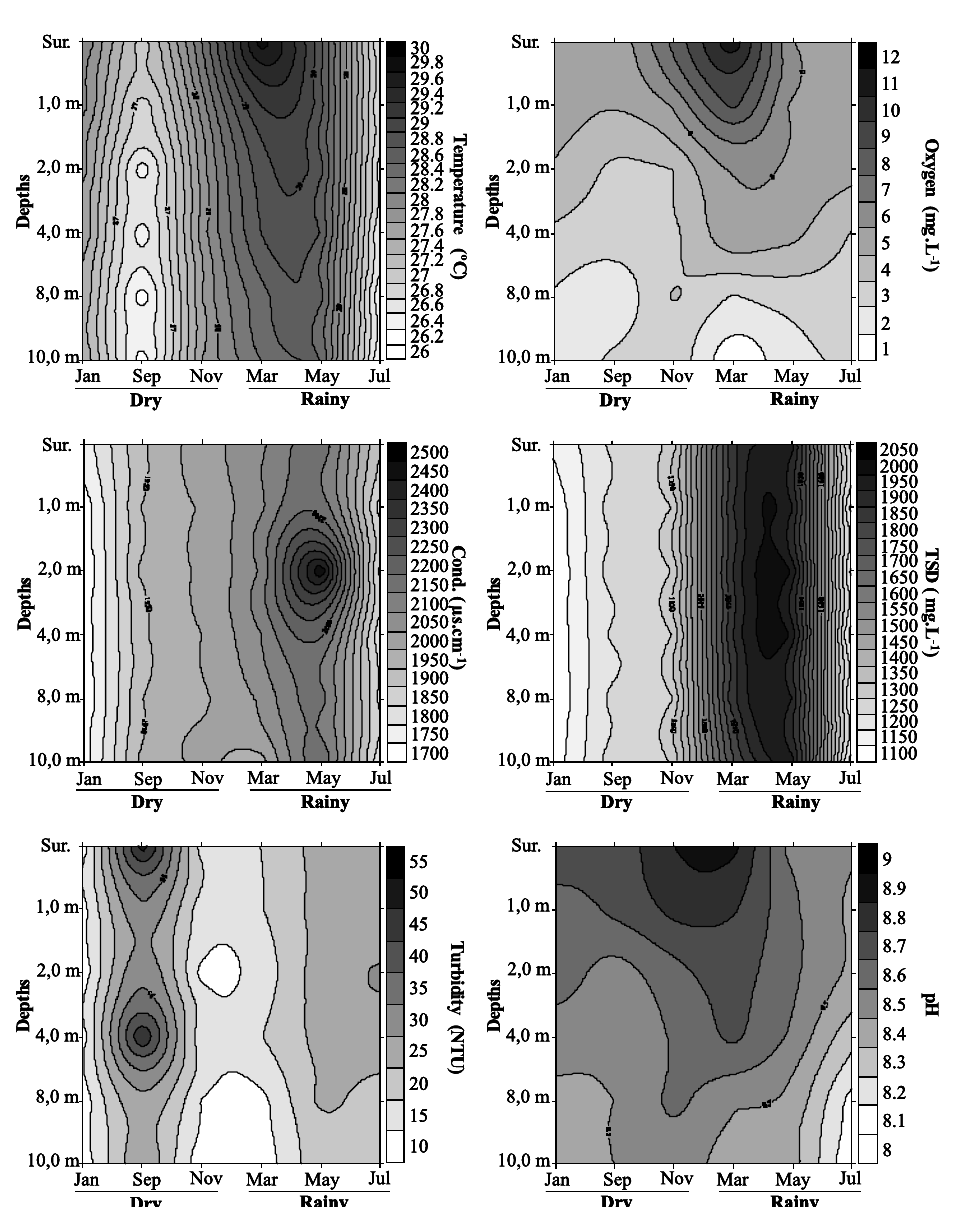
Fig. 1 – Mean seasonal and vertical variation in temperature, dissolved oxygen, electrical conductivity, total dissolved solids, turbidity and pH in the Carpina reservoir (PE, Brazil) from January to November 2006 (DS: dry season; RS: rainy season).